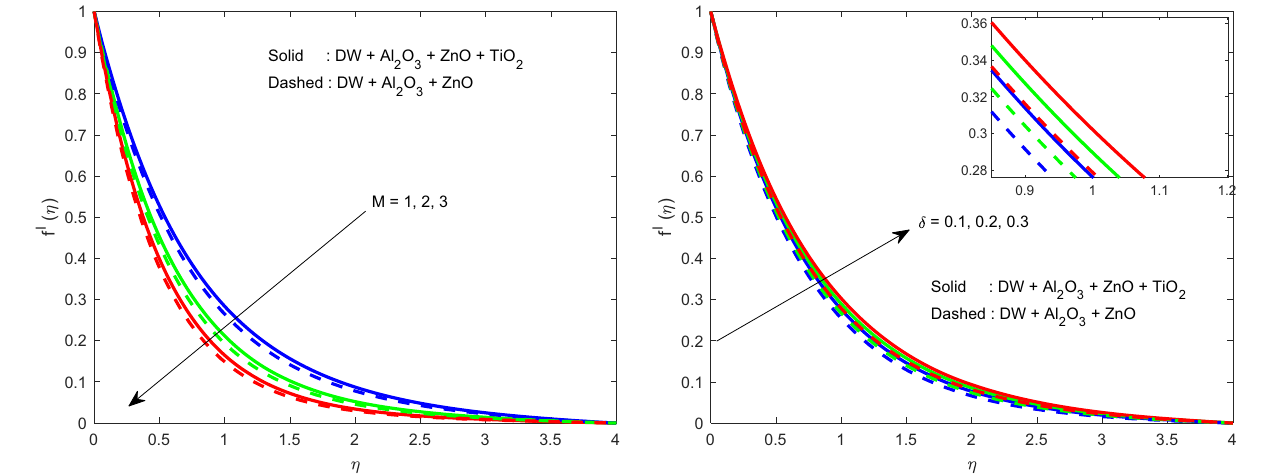
Figure 2: Increasing e ff ects of M on f ′ ( η ) . Figure 4: Increasing e ff ects of δ on f ′ ( η ) .